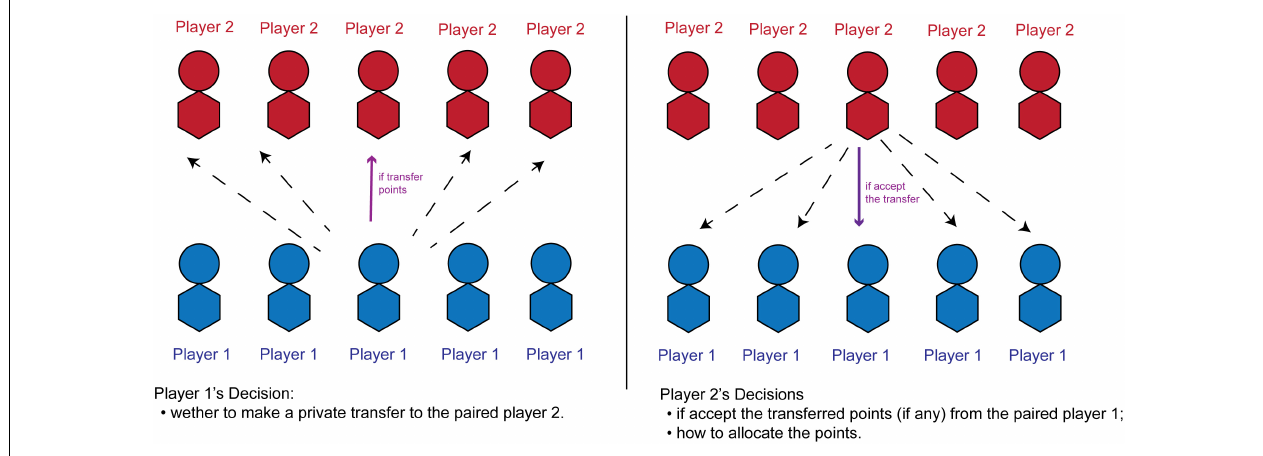
FIGURE 1 | The basic setup of the players’